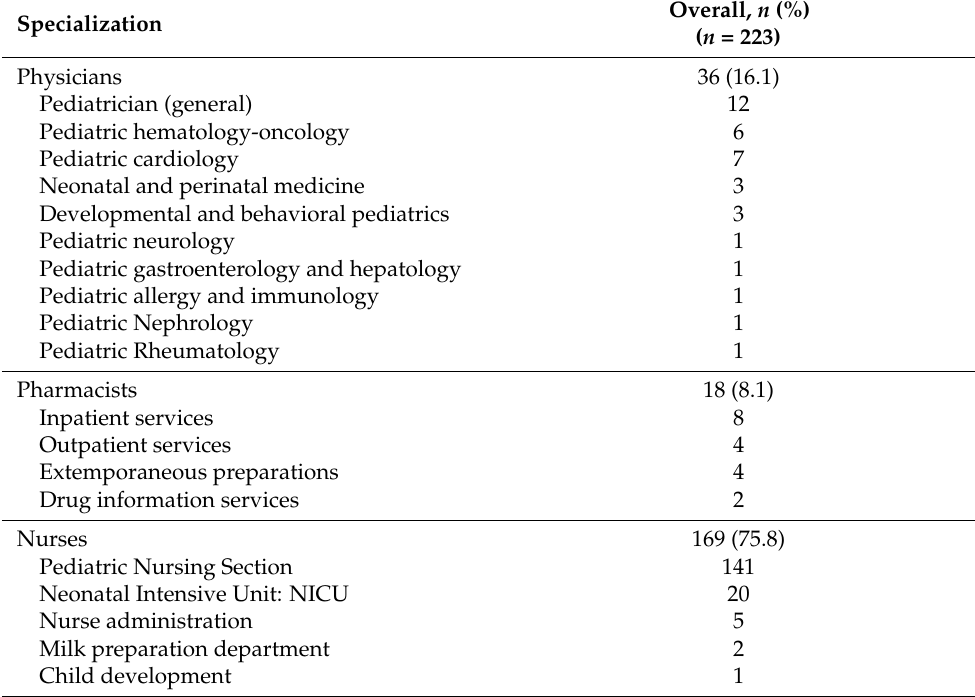
Table 2. Specialization of study